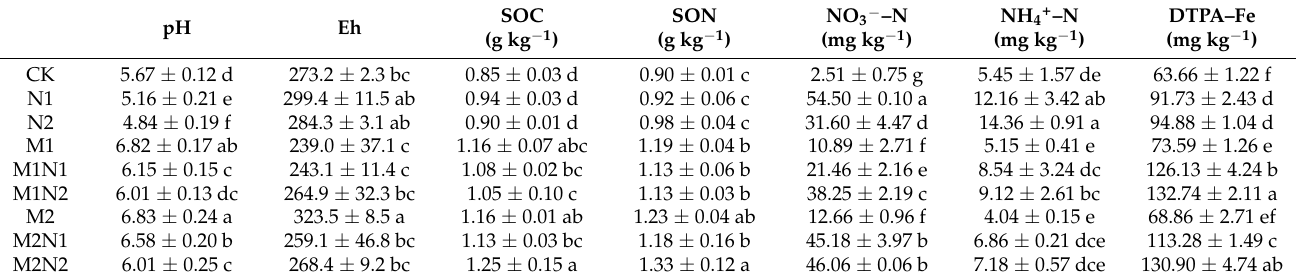
Table 2. Soil physicochemical properties in response to different treatments.